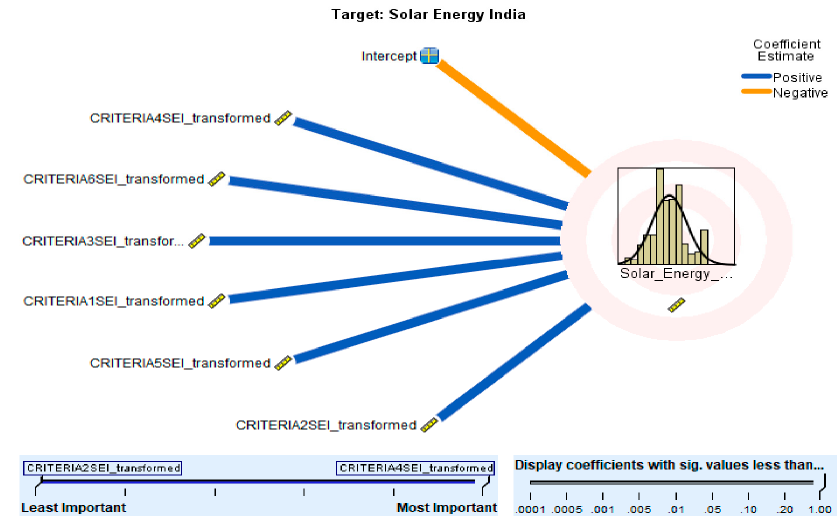
Figure 7. SE India GCV Criteria. Source: ALM Analysis SPSS by Author.